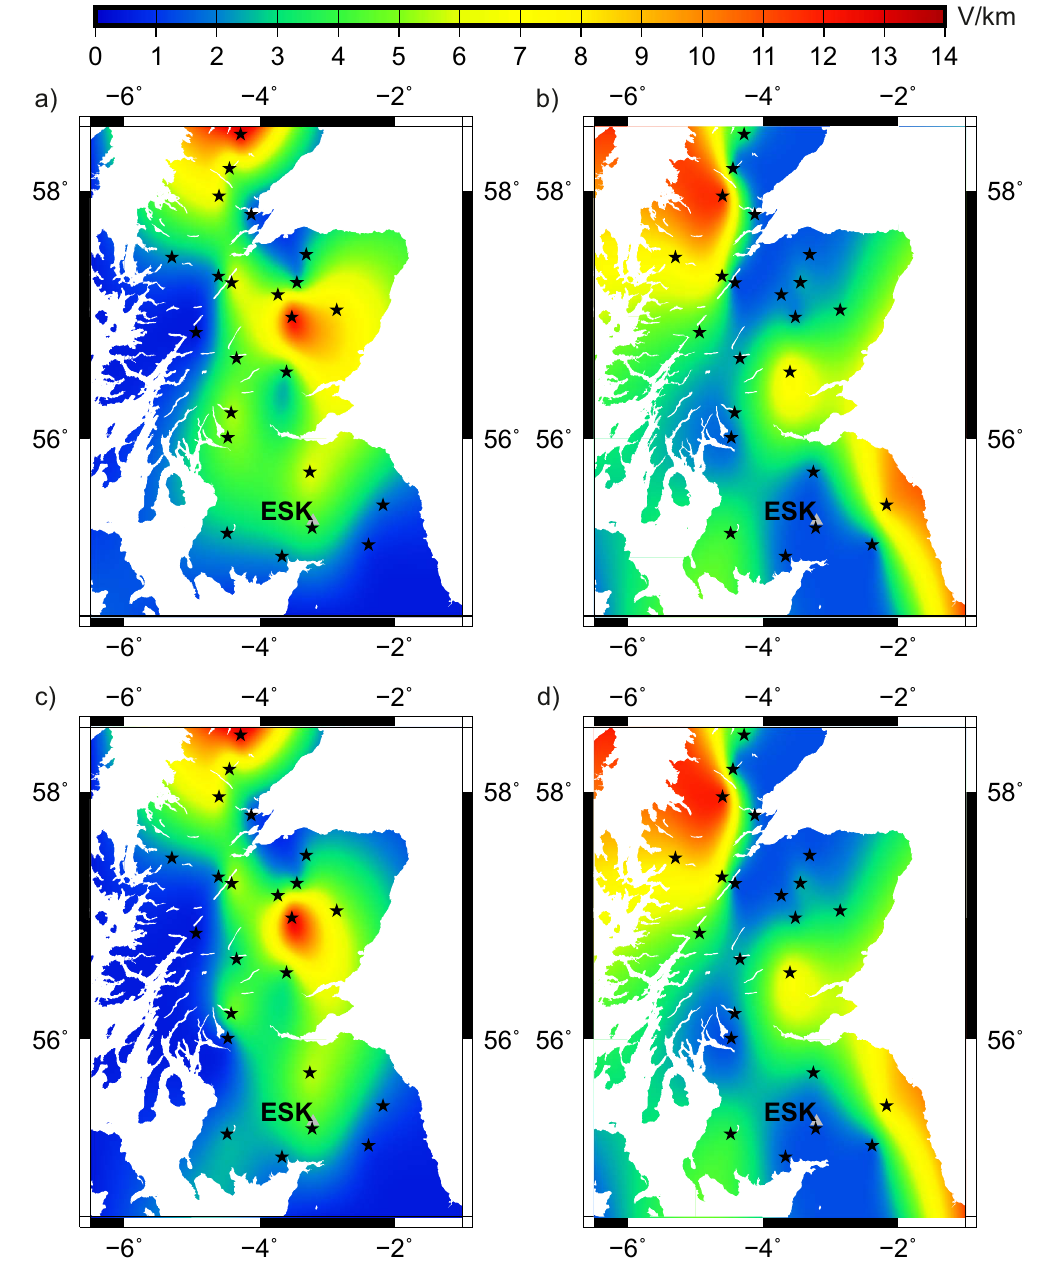
Fig. 7. Bicubic-spline interpolated (Smith & Wessel, 1990), maximum peak-to-peak, Halloween storm-time, electric fi eld magnitudes at 21:20 UT on 30th October 2003 for (a) E x and (b) E y polarisation using measured impedances ( Z ij ); c) E x and d) E y polarisation using modi fi ed impedances ( Z 0 ). Stars indicate impedance-tensor site ij at those sites. This substitution has the largest effect for Lines 4, 5 and 2, which are closest to sites MAR, TAN, ELC and Figure 1 during the September 2017 magnetic storm. In Table 2, CAI (Fig. 1). Electric fi elds only reach approximately 1 V/km we compare line-averaged electric fi elds and transmission-line along Lines 4 and 9. As with the Halloween 2003 storm, the and the measured storm-time mag- voltages estimated from Z largest voltages occur along Line 5 due to its longer length. Site ij netic fi elds at RAN (Simpson & Bahr, 2020b) with those that ACH is suf fi ciently far from north-south oriented, long-distance, ) from sites ACH, result when measured electric fi elds ( E high-voltage power transmission lines that the anomalously meas fi elds measured here do not in fl uence transmission-line ELC, CAI, TAN, MAR, LEA and RAN (Simpson & Bahr, large E x voltages. However, these anomalous fi elds serve to illustrate the